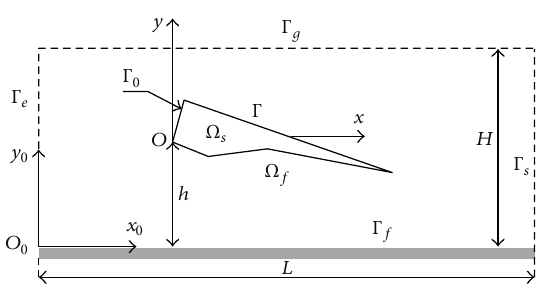
Figure 2: 2D computational